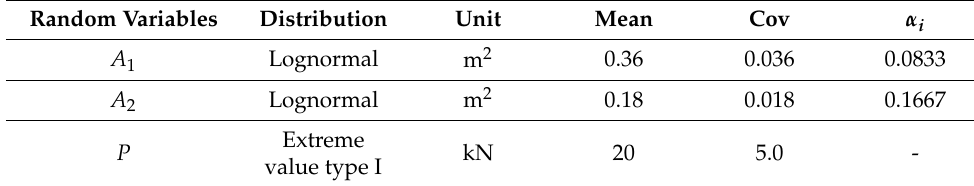
Figure 5. Planar frame structure. Table 7. The statistical parameters in Case